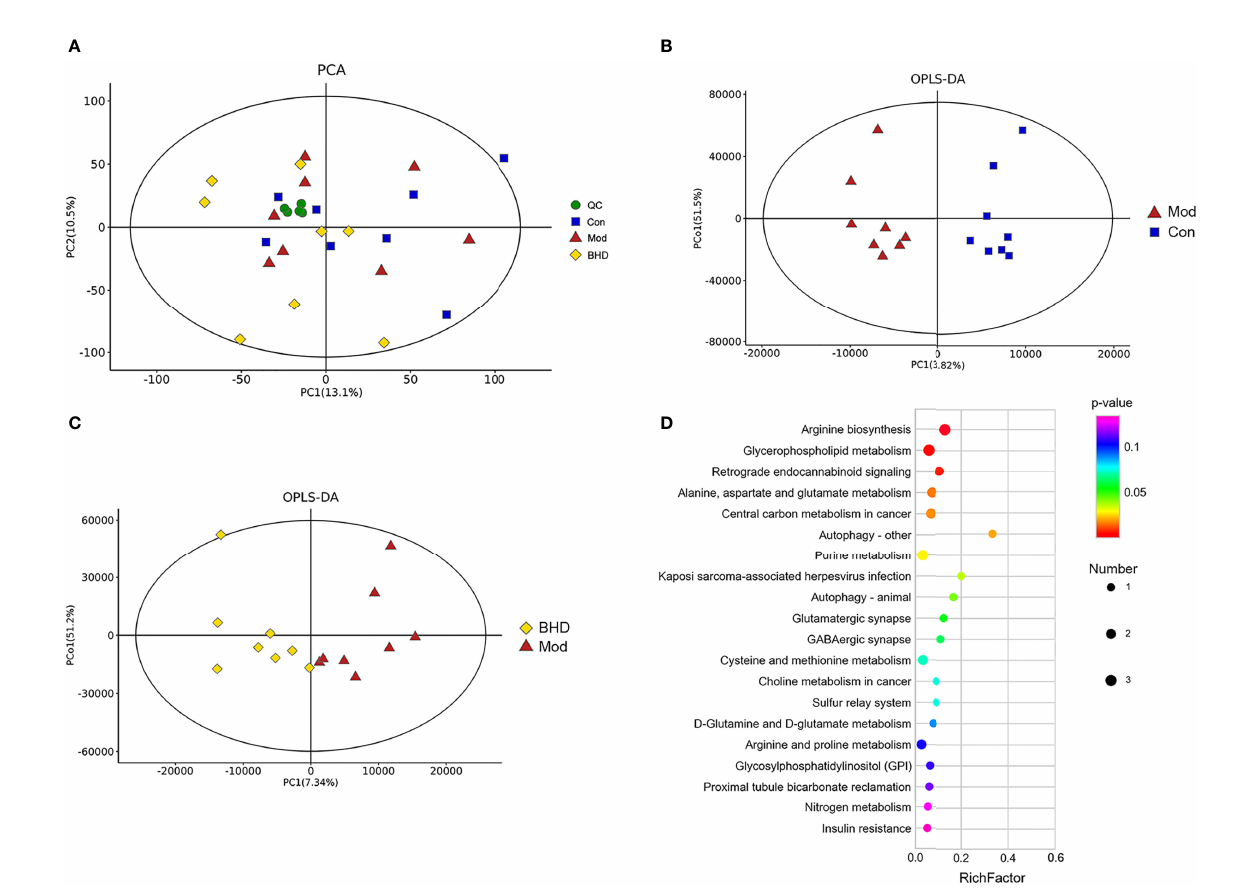
FIGURE 6 | BHD regulated hippocampal metabolism in rats with CI. (A) Hippocampal metabolite analysis of the three groups based on PCA. QC, quality control. (B) Score plots of OPLS-DA between the control and model groups. (C) Score plots of OPLS-DA between the BHD and model groups. (D) Bubble diagram of the metabolic enrichment pathways based on the differentially abundant metabolites among the three groups. The x-axis shows the Rich factor, the color of the circle indicates the p value , and the size of the circle re fl ects the number of differentially abundant metabolites in each pathway. n = 8 per